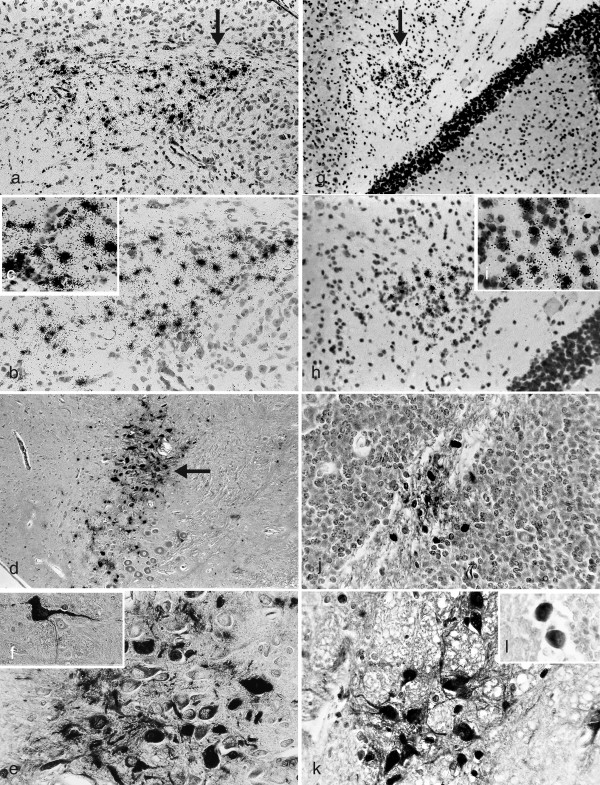
'Focal' areas of HSV-1 DNA and antigen positive cells develop sequentially in non-contiguous areas of the BST and CB of PL/J mice. Brains from 10-12 week ♀ PL/J mice, infected with HSV-1 via the oral mucosa, were examined for viral DNA and antigen. Serial sections of the brain were examined for 35S-labelled HSV DNA (ISH) and viral antigens (IHC) and counterstained with either H & E or CFV respectively. 'Focal' areas of 35S-labelled HSV-1 DNA (Figure 3 a-c) and viral antigen (Figure 3 d-f) positive cells are identified in the BST (a) A 'focal' area of HSV-1 DNA positive cells in the BST (arrow), 3 days PI (x100) (b) Higher power photomicrograph, 3 days PI (x 200) (c) High power photomicrograph, 3 days PI (x400) (d) A 'focal' area of viral antigen positive cells in the BST (arrow), 5 days PI (x100) (e) Higher power photomicrograph, 5 days PI (x400) (f) Higher power photomicrograph of viral antigen positive neuron, 5 days PI (x400). 'Focal' areas of 35S-labelled HSV-1 DNA (Figure 3g-i) and viral antigen (Figure 3 j-l) positive cells are identified in the CB. (g) A 'focal' area of HSV-1 DNA positive cells in the CB (arrow), 5 days PI (x100) (h) Higher power photomicrograph, 5 days PI (x200) (i) High power photomicrograph, 5 days PI (x400) (j) A 'focal' area of viral antigen positive cells in the CB, 6 days PI (x200) (k) Higher power photomicrograph, 6 days PI (x400) (l) Higher power photomicrograph of viral antigen positive Purkinje cells, 6 days PI (x400).